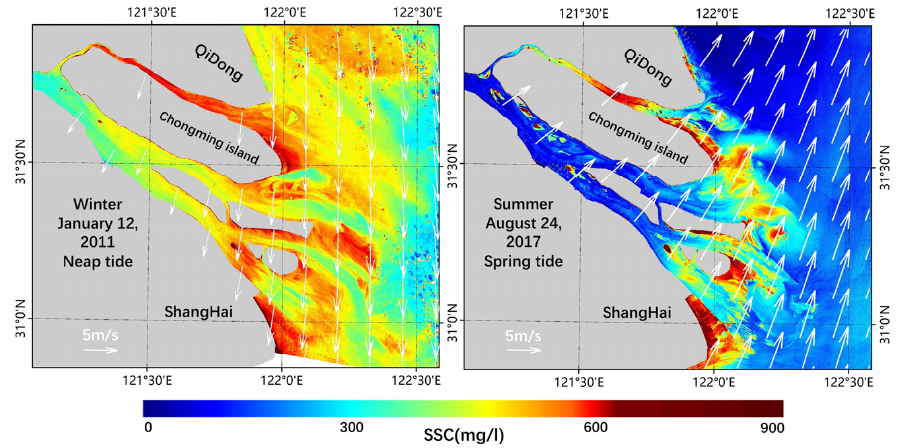
Figure 8. SSC distribution and the wind field in summer and